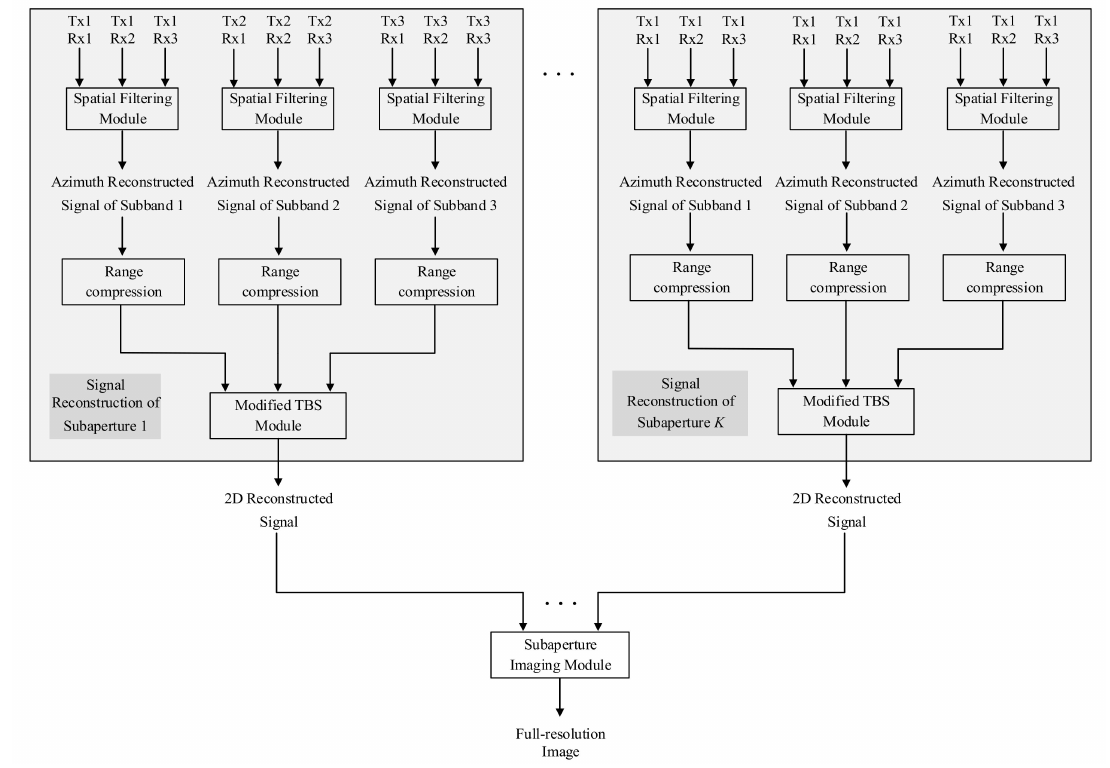
Figure 4. Signal processing flow chart of the model of three transmitters and three receivers.